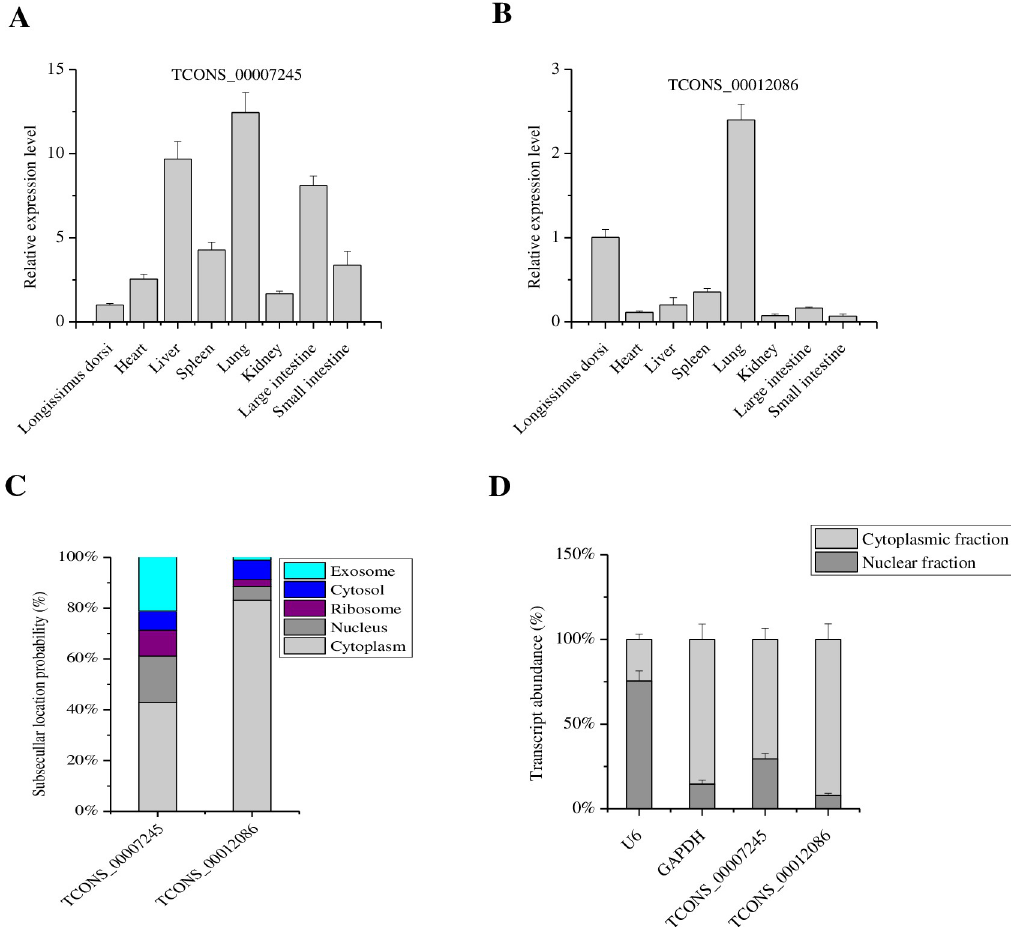
Fig 10. The relative expression levels of TCONS_00007245 (A) and TCONS_00012086 (B) in different Chinese Guizhou Congjiang pig tissues. (C) Prediction of subcellular localization by lncLocator (http://www.csbio.sjtu.edu.cn/bioinf/lncLocator/ ). (D) The nucleocytoplasmic fractionation of porcine cells by qRT-PCR. U6 RNA served as a nuclear location control and GAPDH served as a cytoplasmic location control.